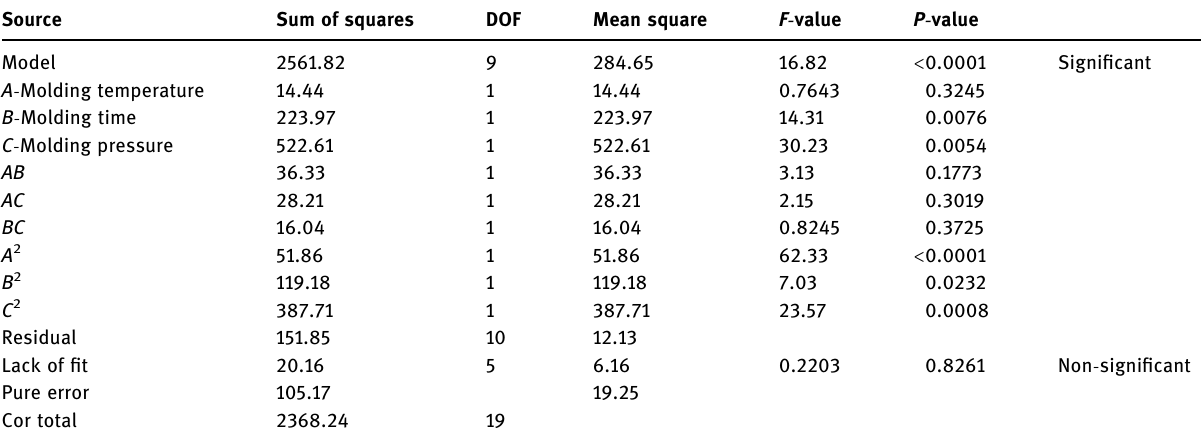
Table 15: ANOVA for abrasion resistance Source Sum of squares DOF